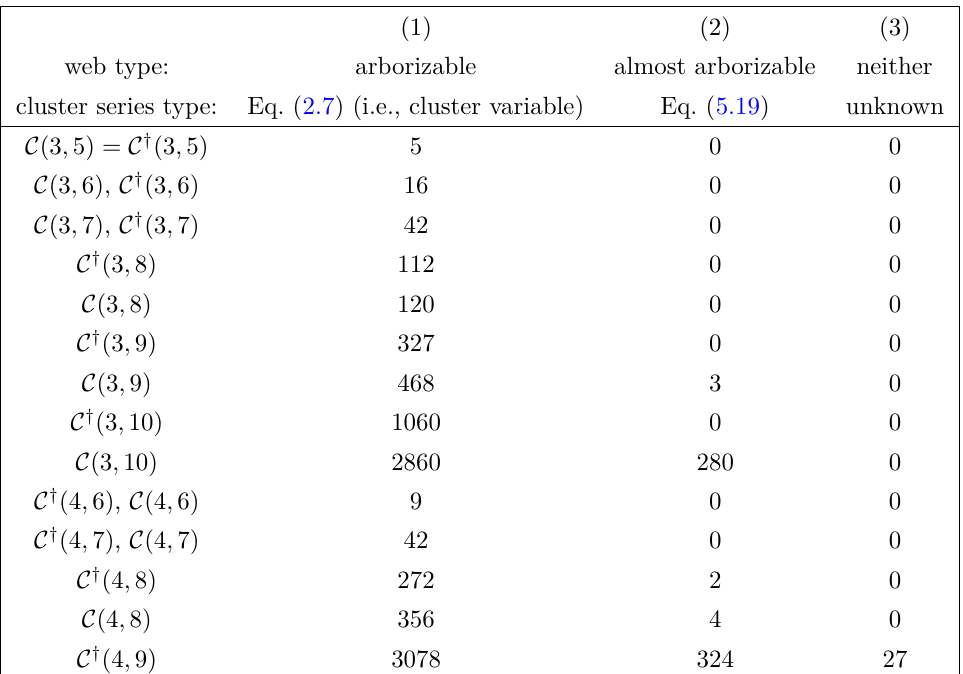
Table 3. The number of facets of types (1), (2) and (3) (defined in the text) for various polytopes. Note that the facets of C † ( k, n ) are always (by construction) a subset of those of C ( k, n ) . The set of facets associated to each polytope is closed under the action of the Z n cyclic group, and for the C † polytopes they are closed under the full D n dihedral group as well as under parity (see appendix A of [1] for a discussion of parity